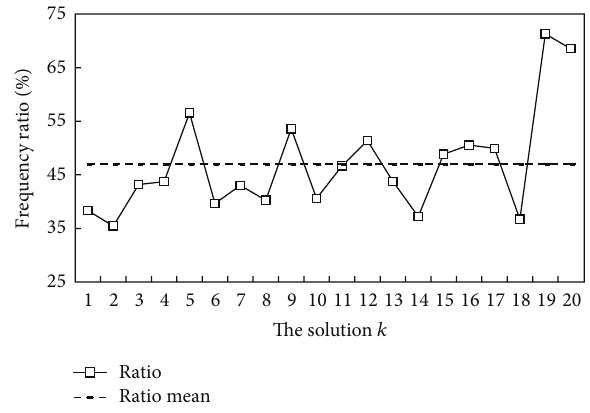
Figure 3: Appearance-frequency ratios of 𝑅 DNASDmining solu- tions, where 𝑘 = 1,2,...,𝑅 . The mean frequency ratio is 47.0% for HPL